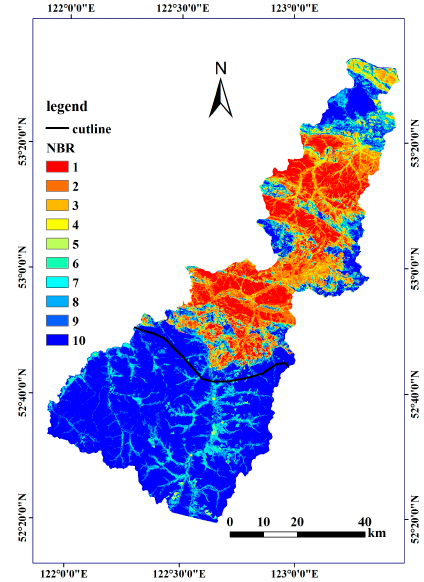
Figure 6. The NBR-extracted fire intensity map. A cutline is manually drawn to generally separate the burned areas in the north and unburned areas in the south of the study area.